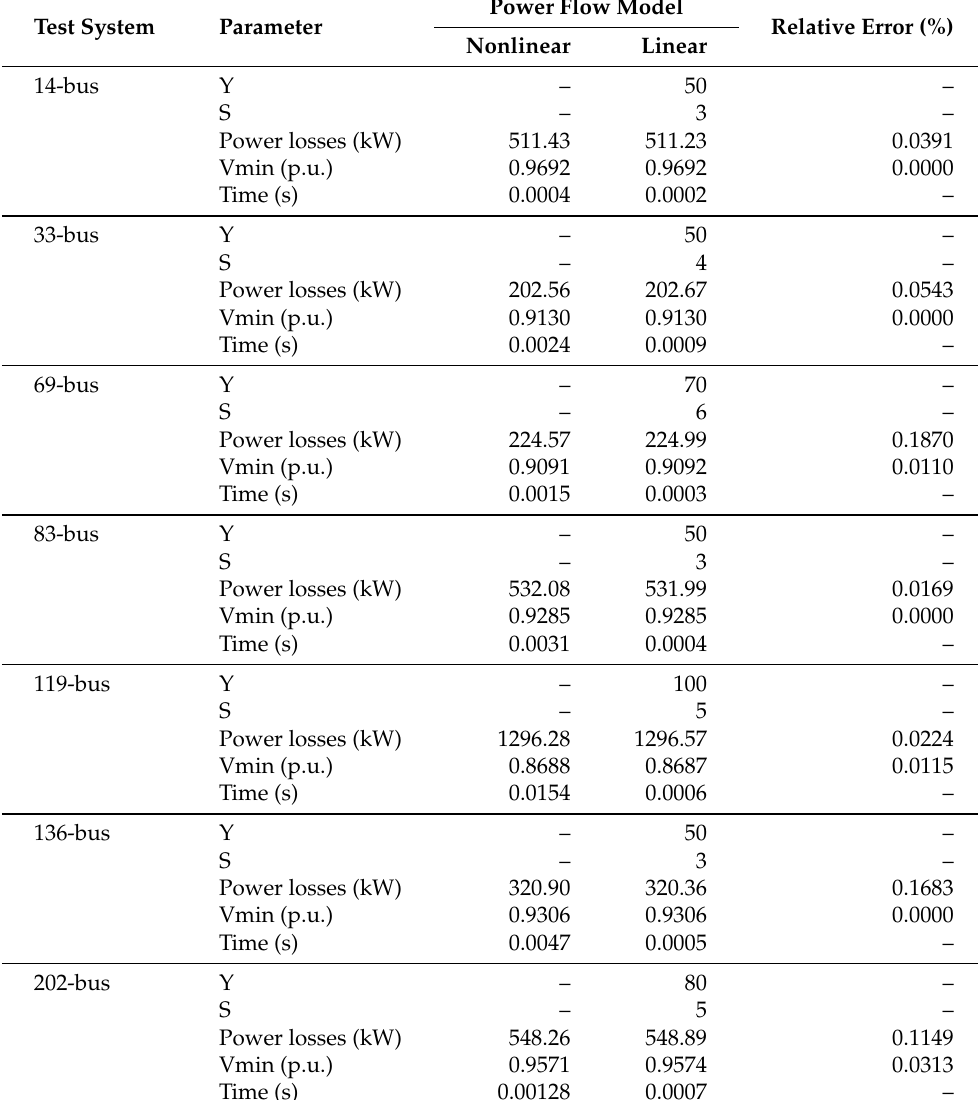
Table 1. Nonlinear vs. linear power flow